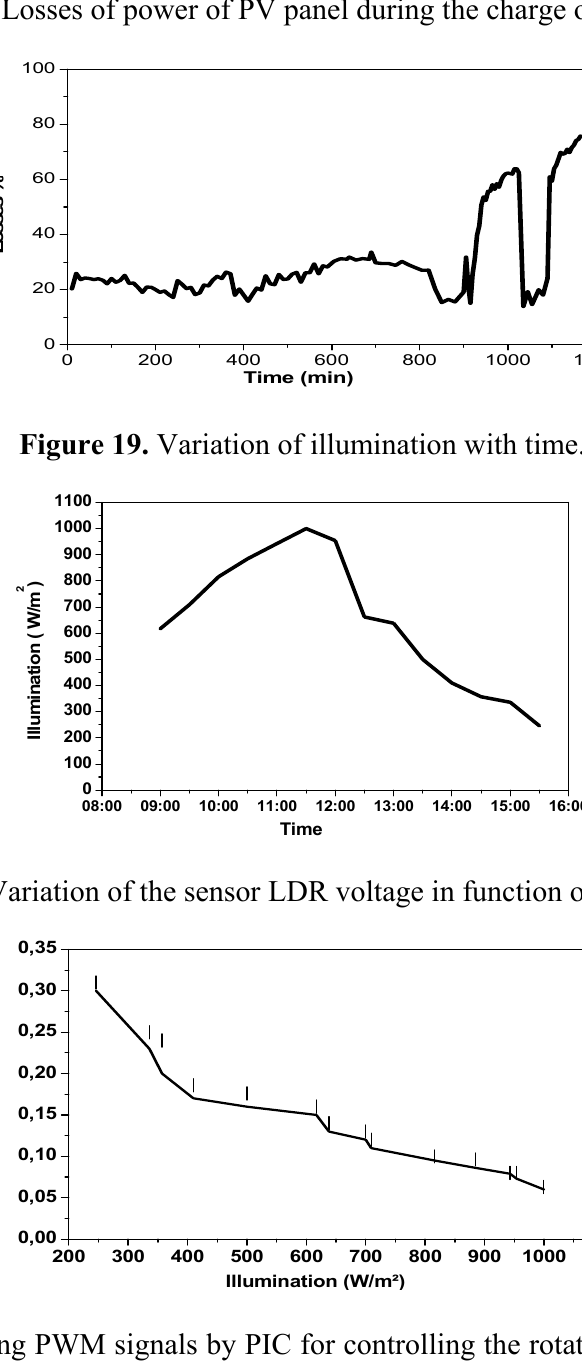
Figure 18. Losses of power of PV panel during the charge of the battery.